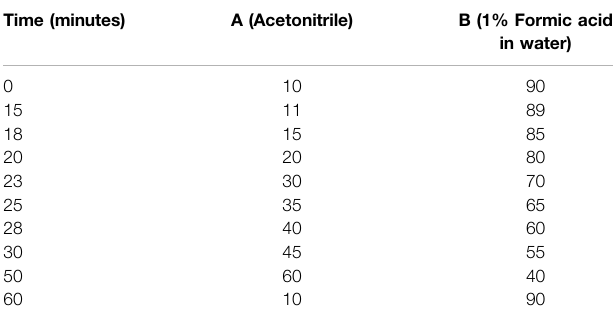
TABLE 1 | Chromatographic gradient for LCTOFMS analysis. TABLE 2 | TPC and TFC of B. acmella